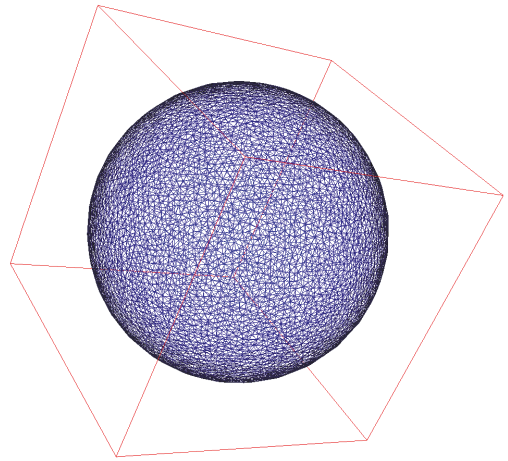
Figure 15: The sphere domain with computational grid.